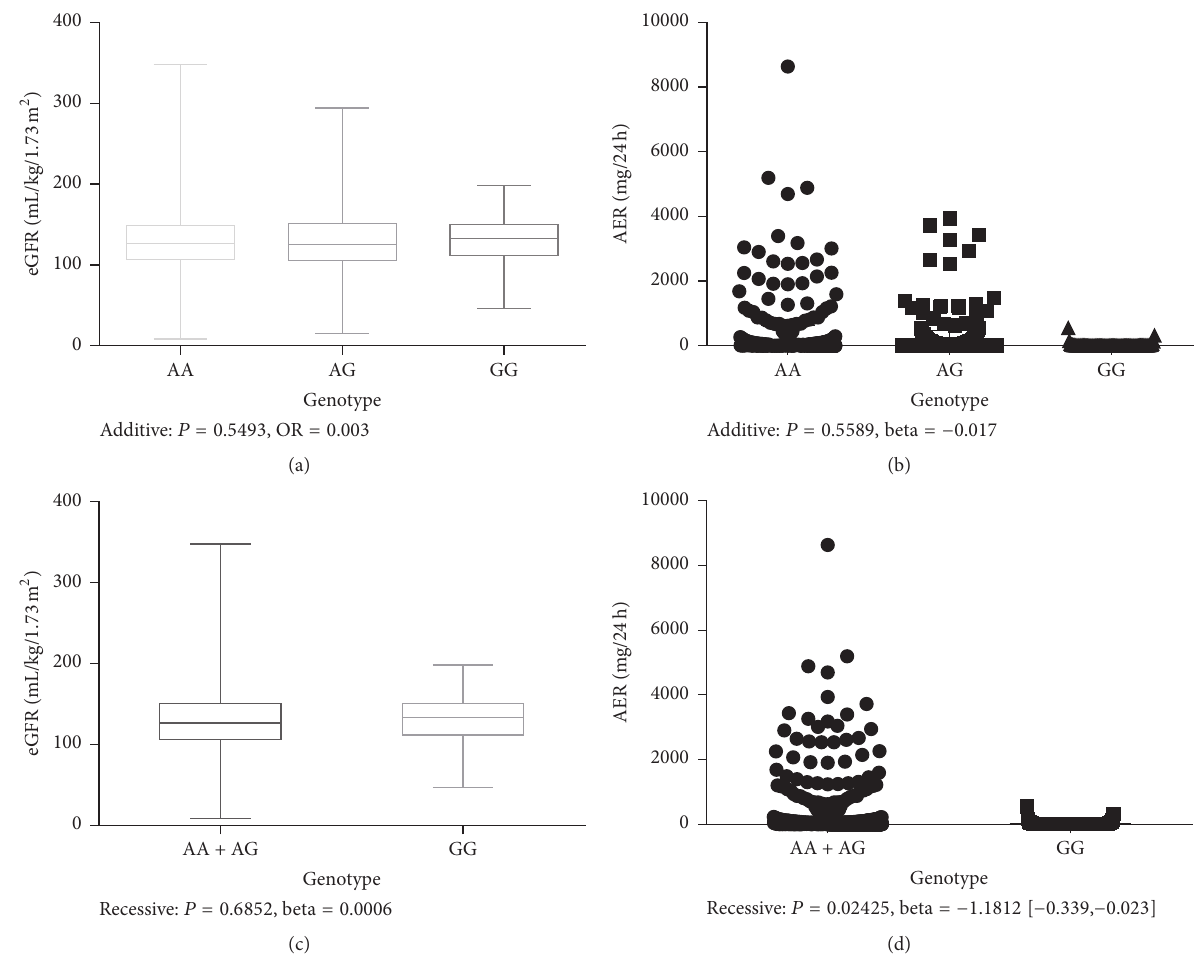
Figure 2: The difference of eGFR and AER in different genotypes. Box plot (a) shows the association of rs955333 with eGFR on additive model. Scatter plot (b) shows the association of rs955333 with AER on additive model. Box plot (c) shows the association of rs955333 with eGFR on recessive model. Scatter plot (d) shows the association of rs955333 with AER on recessive model. 𝑃 values and beta values were determined by multiple linear regression adjusting for age, gender, BMI, duration, Hba1c, DP, SP, TC, and